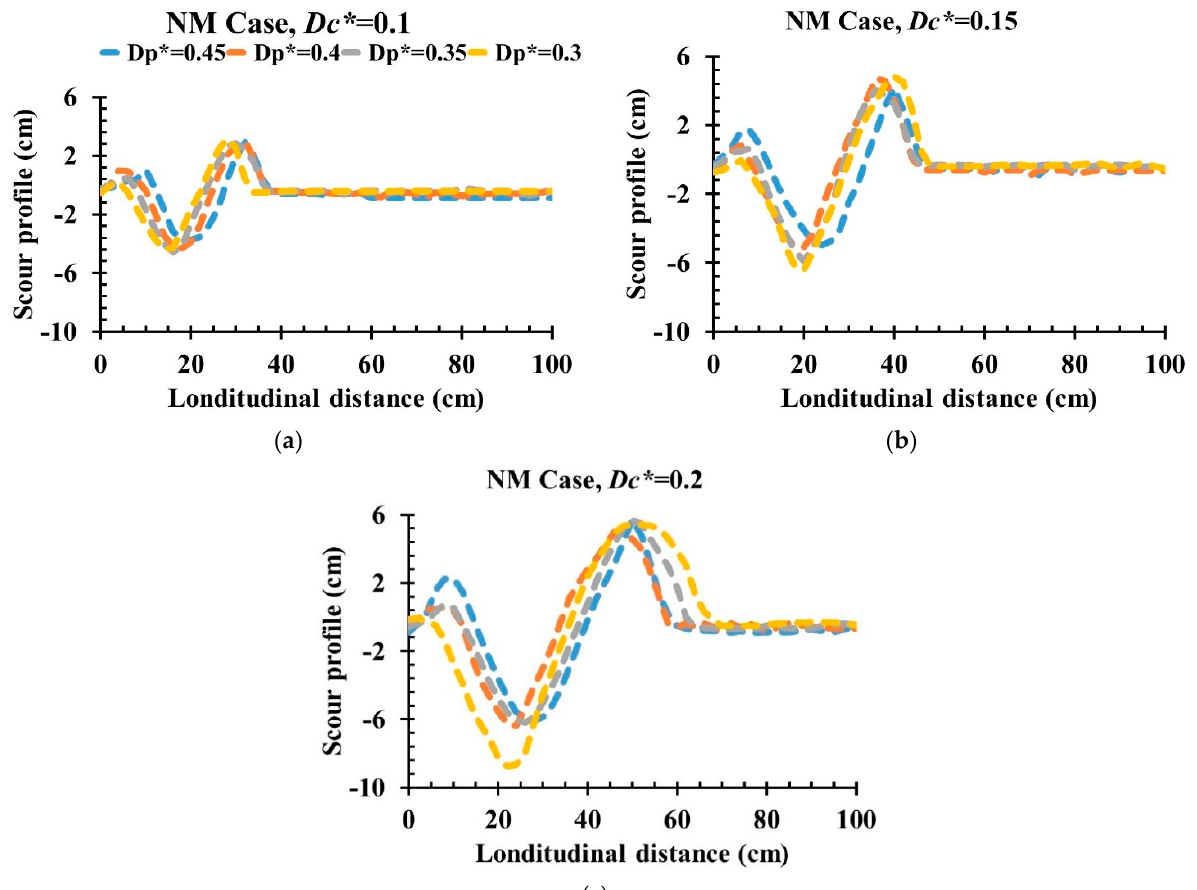
Figure 5. ( a – c ) Scour profile during NM case (nothing case): ( a ) during 𝑫 𝒄 ∗ = 0.1; ( b ) during 𝑫 𝒄 ∗ = 0.15; ( c ) during 𝑫 𝒄 ∗ = 0.2.